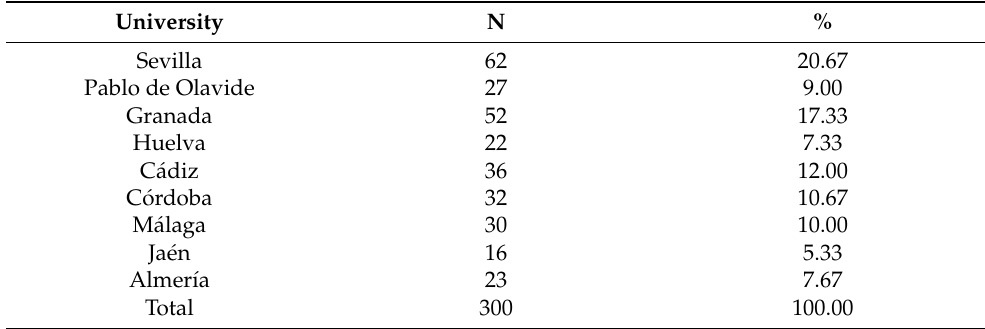
Table 2. Participation index by Andalusian universities